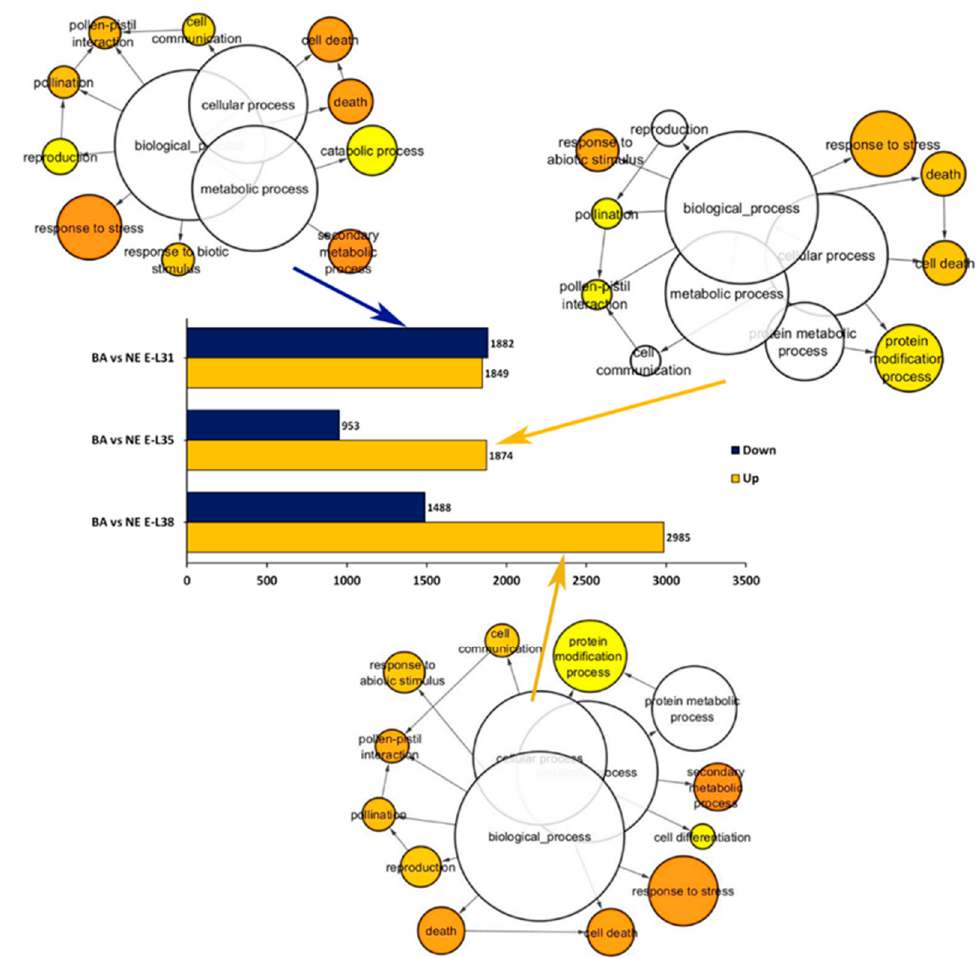
Figure 1. Transcriptome analysis of ‘Nebbiolo’ CVT71 (NE) and ‘Barbera’ CVT115 (BA) berries collected in 2013 at three developmental stages: pea size (E-L31), véraison (E-L35), and harvest at 24 ◦ BRIX (E-L38). The number of differentially expressed genes (DEGs), up (UP) or down (DOWN) regulated, is shown for each RNA-seq comparison near the bar charts. Significantly enriched Gene Ontology (GO) biological functional categories were identified for each group of DEGs belonging to downregulated genes at E-L31, upregulated genes at E-L35 and E-L38 in ‘Barbera’ using Cytoscape with the BINGO plug-in according to enrichment p -value ( p ≤ 0.05).